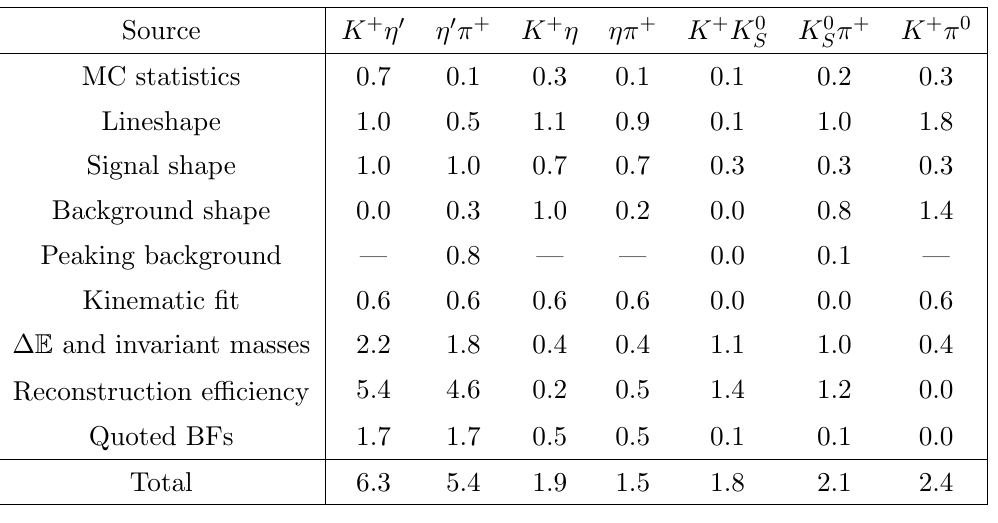
Table 4 . Summary of the systematic uncertainties (in unit of %) for the measurements of relative BFs. The total values are calculated by summing up all contributions in quadrature. modes and the reference decay mode have been partially cancelled when extracting R i in table